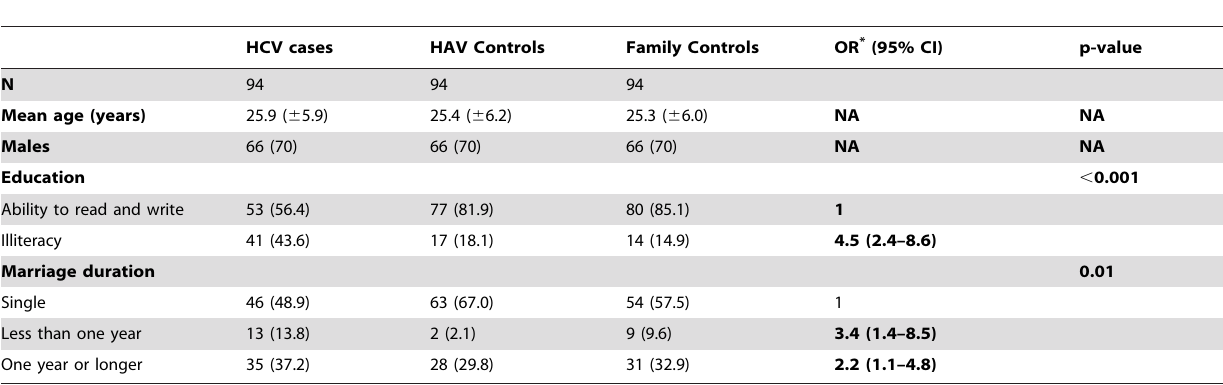
Table 1. Socio-demographic characteristics of acute hepatitis C cases and controls sex- and 6 1 year age-matched, Greater Cairo,